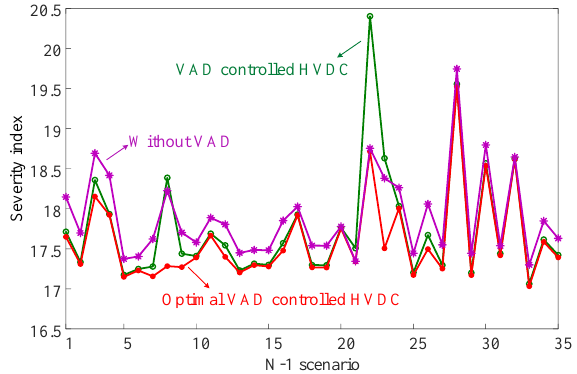
Fig. 4. The severity index results for the three control strategies.